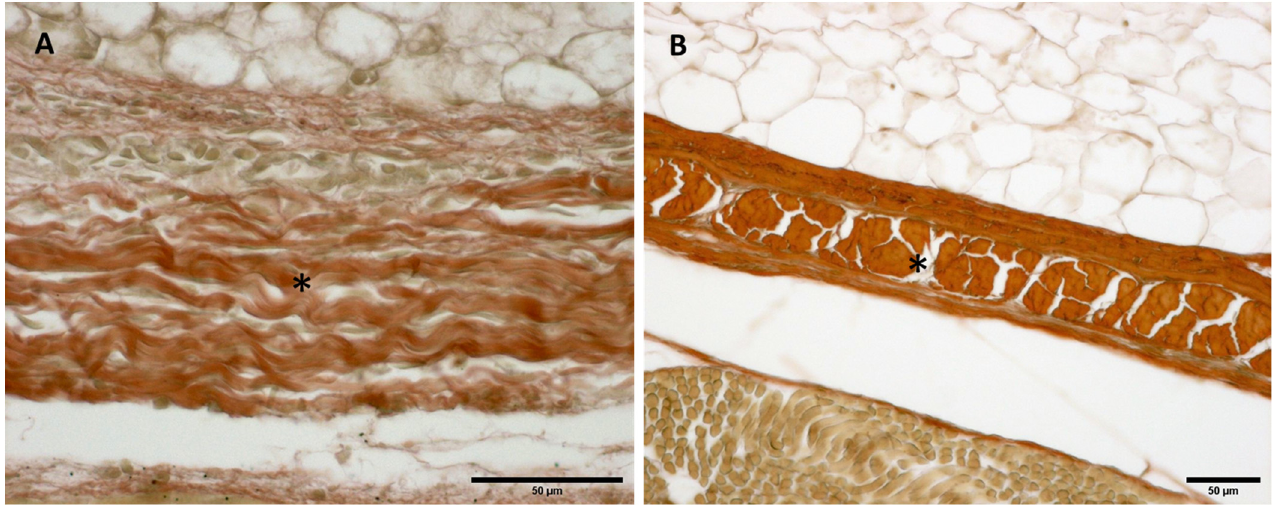
Figure 9. Histological images (Weigert Van Gieson staining): Lateral deep fascia of the thigh: ( A ) 24 weeks; ( B ) 38 weeks. (*): deep fascia. Elastic fibers, by Weigert Van Gieson staining, were present in a negligible percentage, less than 1% at all ages.